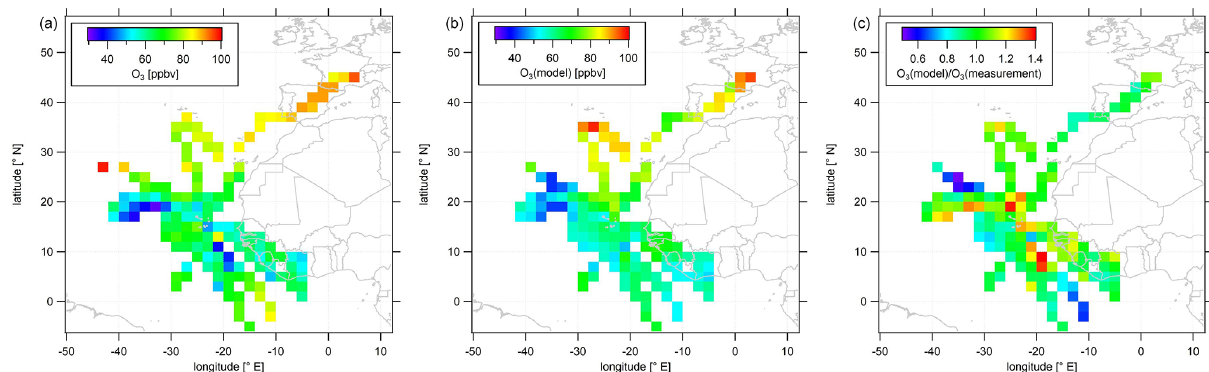
Figure 4. Color-coded spatial, tropospheric O 3 distributions above 12km during CAFE-Africa. Panels (a, b) show the spatial distribution of measured and simulated O 3 , respectively. Panel (c) shows the spatial distribution of the O 3 ( model )/ O 3 ( measurement ) ratio. The figures have been filtered for stratospheric measurements by removing data points for which O 3 exceeds